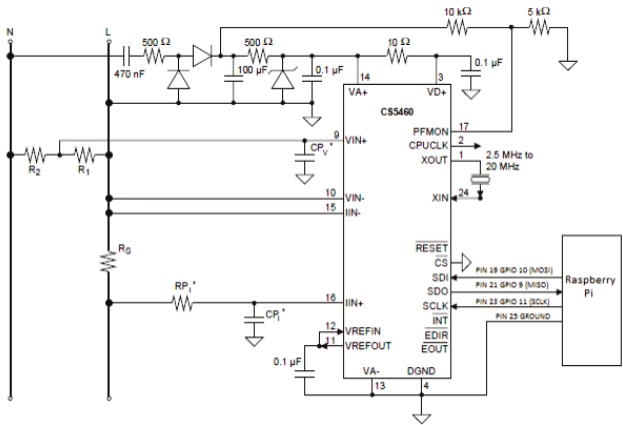
meter as an element that supports in the integration of TCM in EMS.